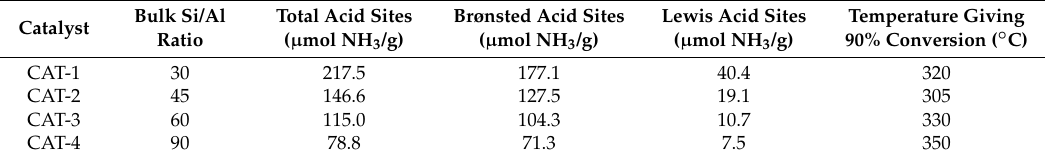
Table 4. Acidity properties of H-ZSM-22 catalysts with various Si/Al ratios and their reaction temperatures for obtaining 90% conversion (modified from Reference